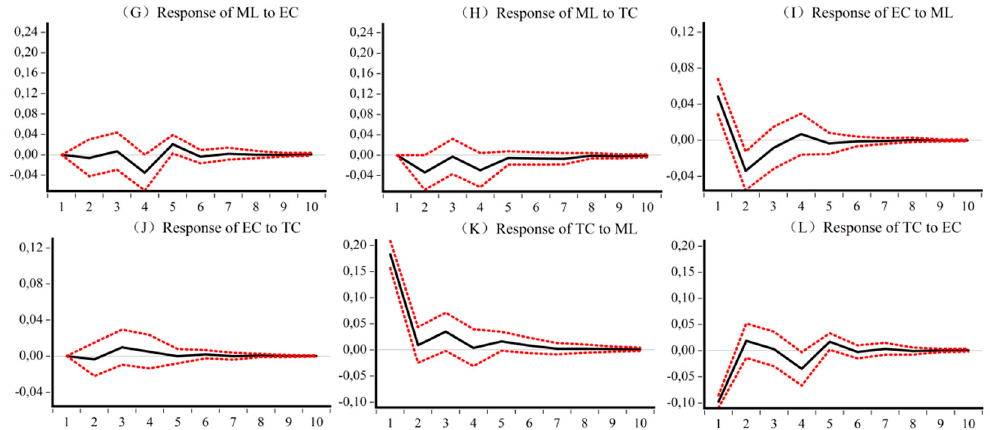
Figure 6. Impulse response results of ML, EC, and TC of Eastern CEE. ( G ) Response of ML to EC ( H ) Response of ML to TC ( I ) Response of EC to ML ( J ) Response of EC to TC ( K ) Response of TC to ML ( L ) Response of TC to EC.